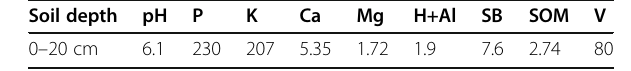
Table 1 Chemical properties of the soil in Parque Jardim da Conquista, the site of litterfall material exposure. pH potential of hydrogen, P phosphorus (mg/dm 3 ), K potassium (mg/dm 3 ), Ca calcium (cmolc/dm 3 ), Mg magnesium (cmolc/dm 3 ),